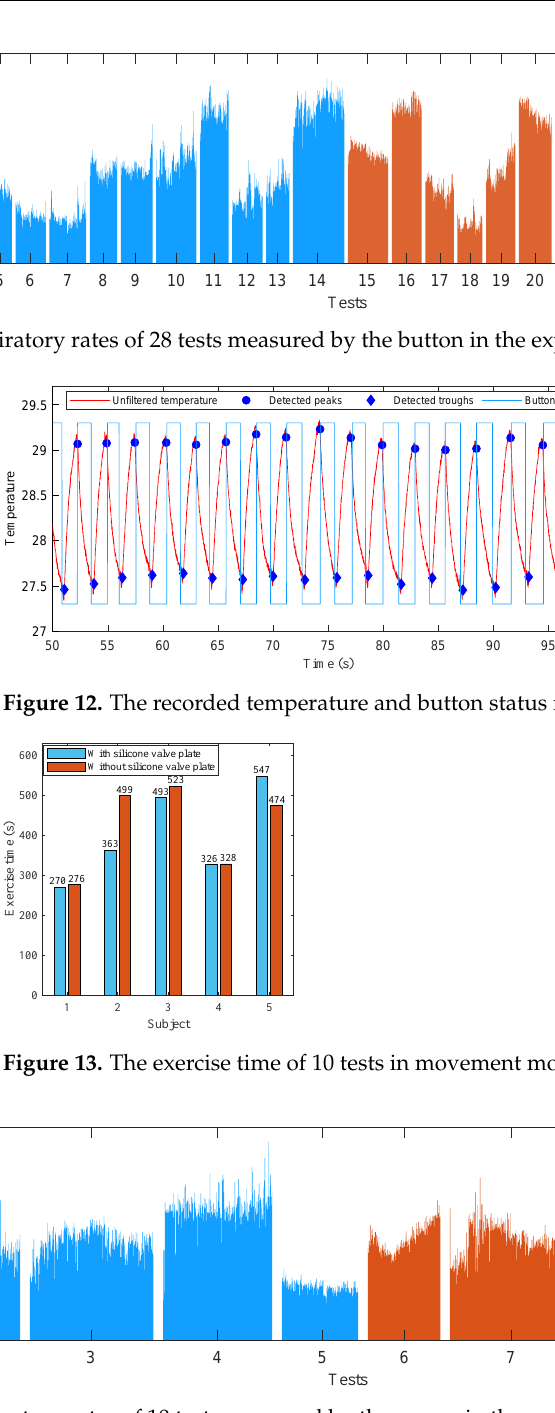
Figure 16. The total 2592 measurement pairs show a very high correlation coefficient (r) of 0.9946, a standard deviation (SD) of 0.62 bpm, a very small mean difference (MD) of − 0.0015 bpm with 95% limits of agreement (LoA) of − 1.216 to 1.213 bpm, a mean absolute error (MAE) of 0.449 bpm and a root mean square error (RMSE) of 0.620 bpm. We